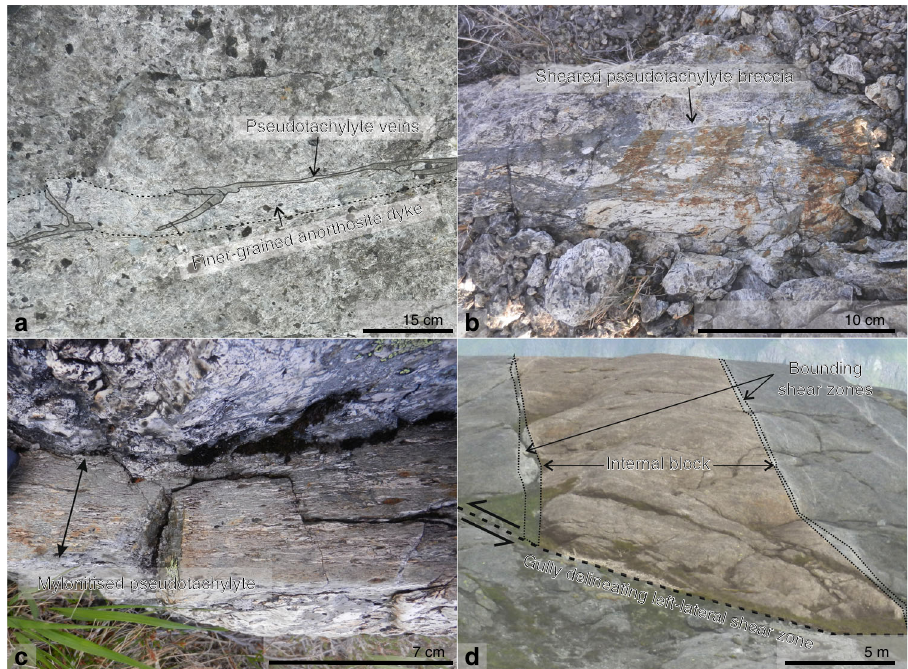
Fig. 2 Shear zones and sheared pseudotachylytes in the Nusfjord anorthosite. a Pseudotachylyte localised along the margin of a relatively fi ne-grained anorthosite dyke. A viscous overprint in the pseudotachylyte can be seen in the apparently sheared geometry of the injection veins [68.0563°N 13.3648°E]; b pseudotachylyte fault breccia with viscous overprint shown by alignment of deformed, elongate clasts parallel to the shear zone foliation [68.0572°N 13.3687°E]; c well-foliated mylonite consisting of signi fi cant proportions of pseudotachylyte — interpreted to be a high strain equivalent to the breccia in b. Outside the sheared pseudotachylyte, the anorthosite is undeformed [68.0572 °N 13.3687°E]; d view looking west of an internal anorthosite block (with orange overlay) between two bounding shear zones emphasised in white and detailed in Fig. 3a [68.0557°N